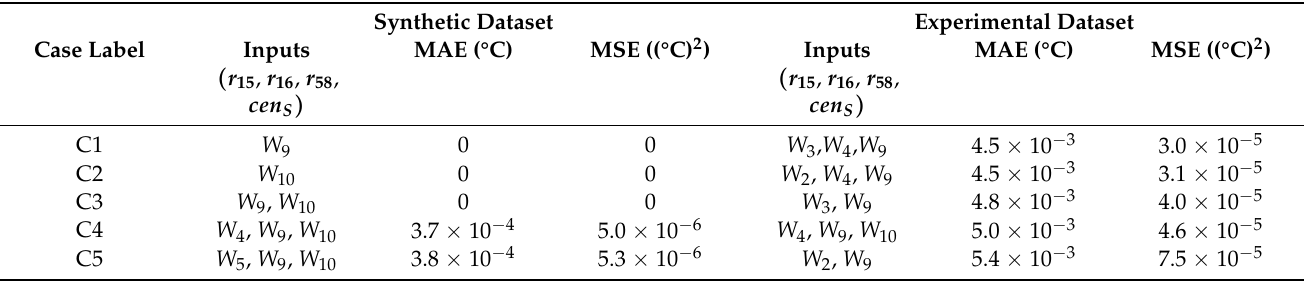
Table 6. MAE and MSE obtained for different combinations of inputs in the FIS for synthetic and experimental datasets of sensor